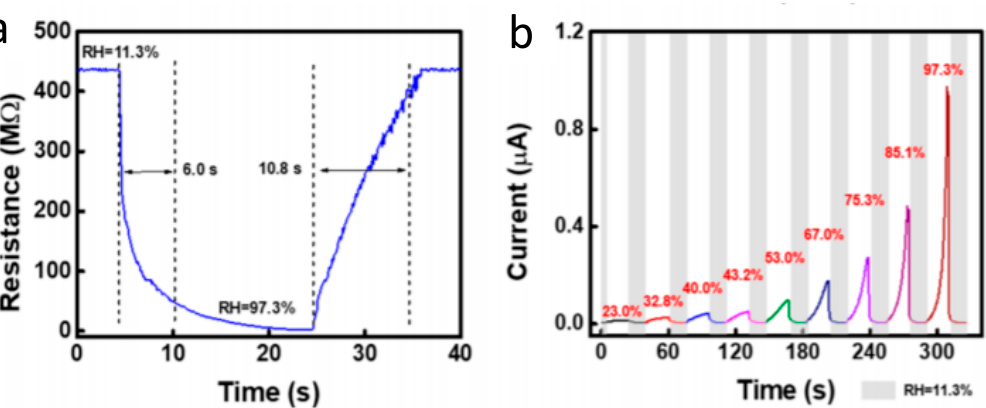
Figure 16. ( a ) Response/recovery times of cellulose/KOH film (CKF) for humidity levels between 11.3